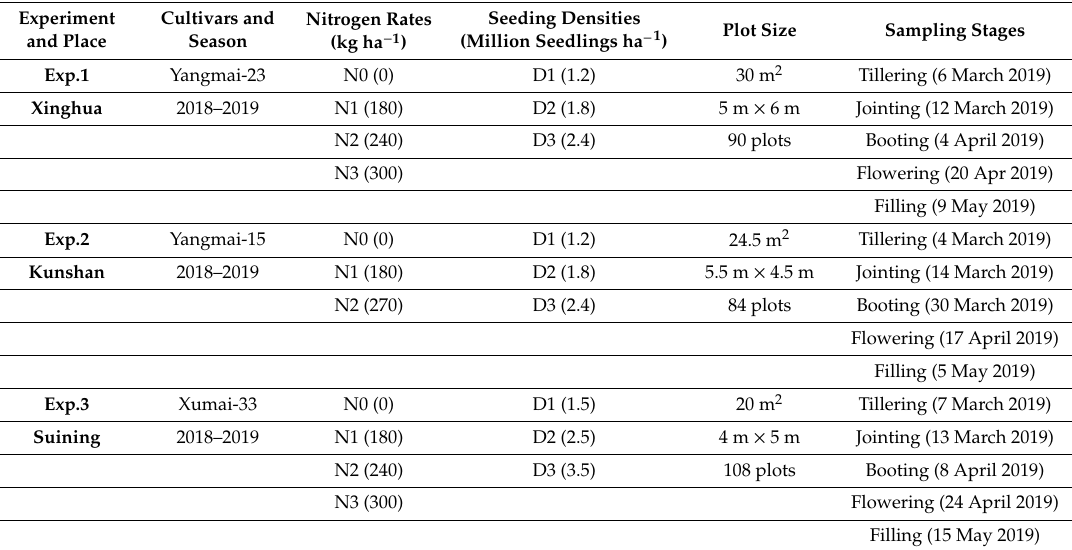
Table 1. Basic information about experimental design and data